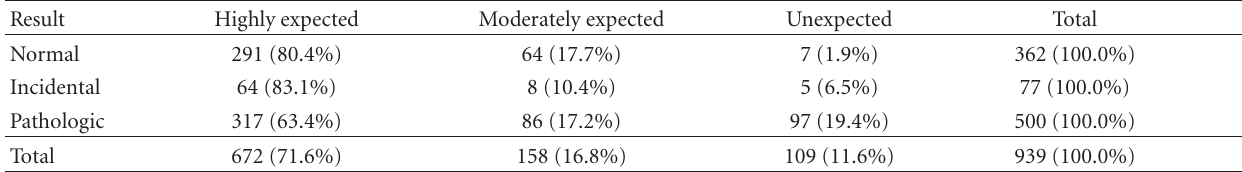
Table 1: Concordance between radiographic outcome and clinician’s expectations in 939 chest radiographs, grouped according to the chest radiography findings. Normal studies had a higher degree of expected outcome than pathologic studies.